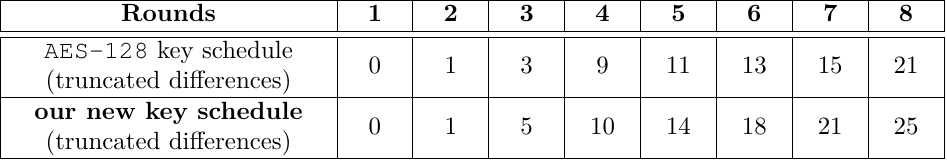
Table 5: Summary of the proven lower bounds on the number of active Sboxes in a related-key differential path for several rounds of AES-128 with the key schedule replaced with our